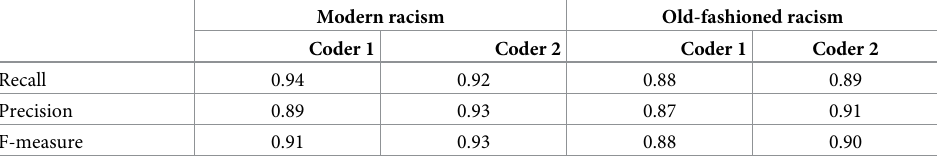
Table 4. The results of the validation of dictionary based extraction for racism. Concordance rates between coders one and two were 0.92 (modern racism) and 0.92 (old-fashioned